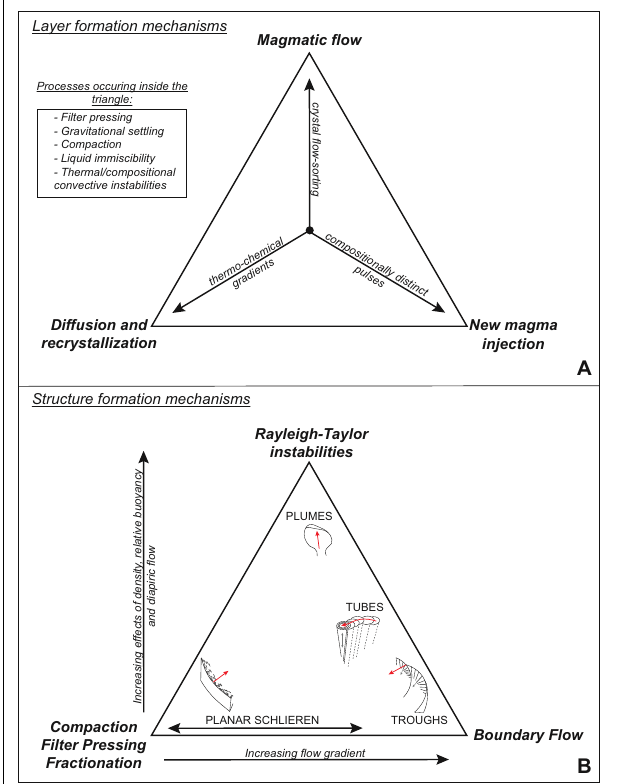
FIGURE 1 | Summary of formation mechanisms for schlieren and different magmatic structures. (A) Layer formation mechanisms. Processes listed in the box can occur in the field inside the triangle and represent combinations of end-member processes (bold). (B) Structure formation mechanisms. A summary of proposed formation mechanisms and how different schlieren-bound structures have been interpreted. Schematic diagrams show the approximate 3D geometries of each structure. Gray arrows represent interpreted motion/flow directions. Red arrows represent younging or migration